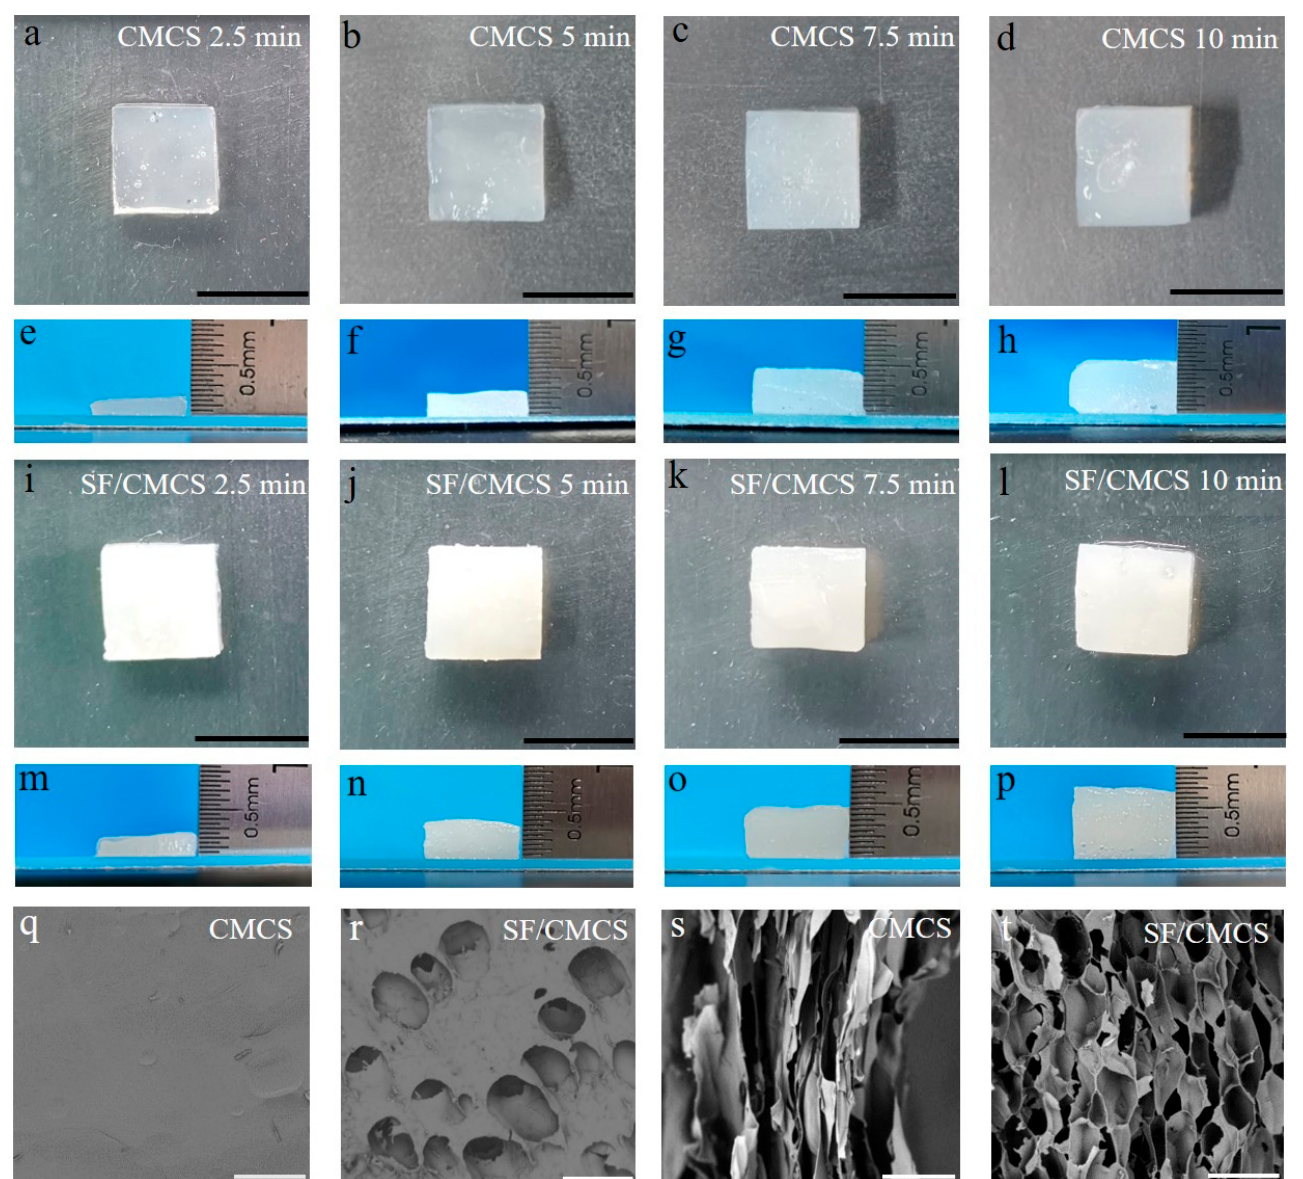
Figure 1. Photographs of the CMCS hydrogels prepared from 2% CMCS solution and the SF/CMCS hydrogels prepared from a 5% SF and 2% CMCS mixture with a DC voltage of 4 V applied for 2.5 min ( a , l ), 5.0 min ( b , j ), 7.5 min ( c , k ), and 10 min ( d , p ). ( e – h , m – p ) are the corresponding side-view images of ( a – d , i – l ), respectively (scale bar: 1 cm). ( q , r ) present the SEM images of the top surface morphology of freeze-dried CMCS hydrogel and SF/CMCS hydrogel, respectively. ( s , t ) exhibit the cross-sectional SEM images of CMCS and SF/CMCS hydrogels, respectively (scale bar: 200 µm).